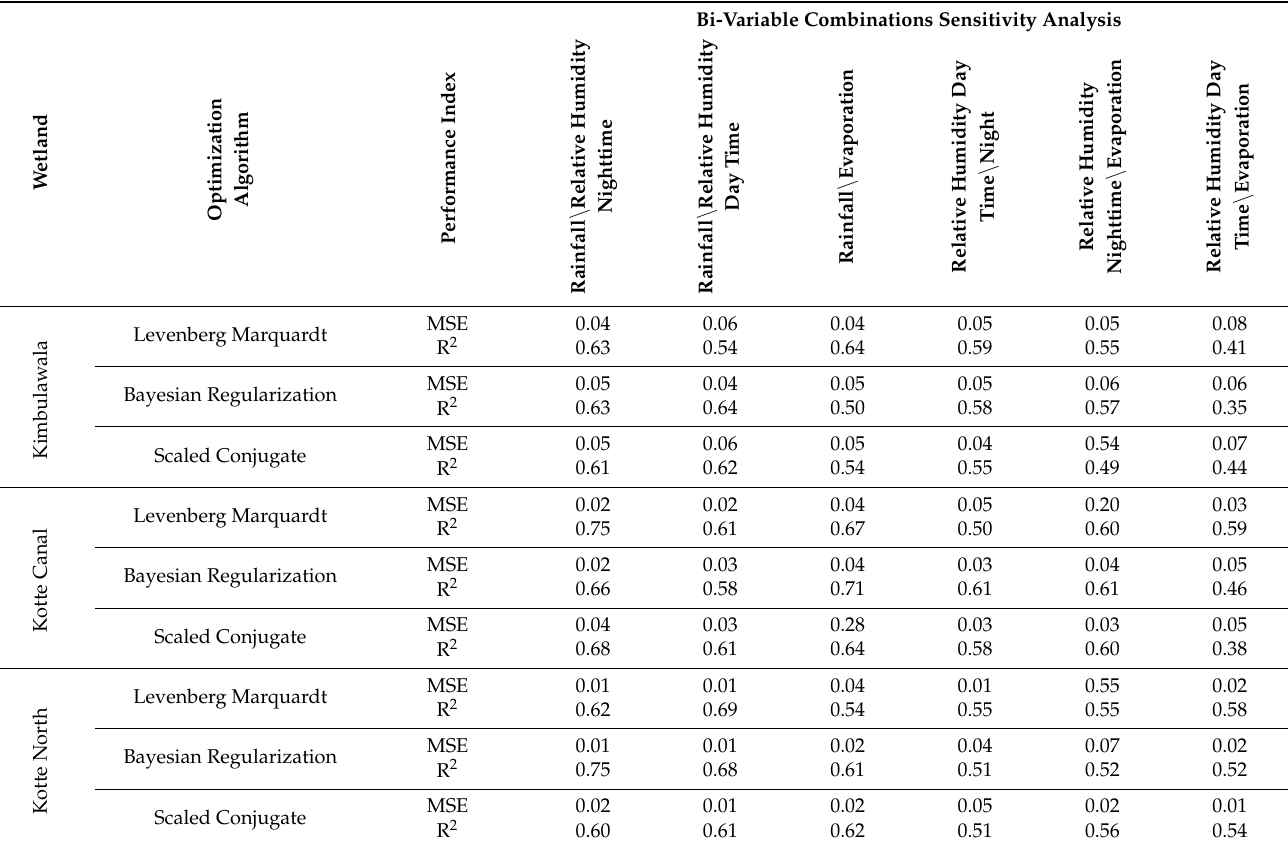
Table 2. Results of bi-variable sensitivity